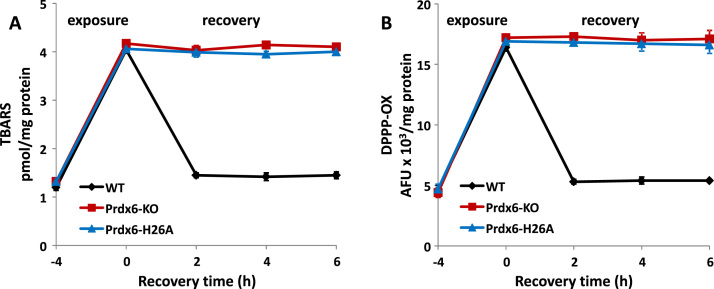
Repair of lipid peroxidation in pulmonary microvascular endothelial cells (PMVEC). PMVEC from Prdx6 null mice were infected with lentivirus to express vector alone (Prdx6 null), Prdx6 wild type (WT), or H26A-Prdx6.Cells were treated with 300 μM (WT) or 200 μM (null, H26A) t-BOOH for 4 h and then evaluated at intervals for recovery in medium free of t-BOOH by assay of: A. TBARS and B. DPPP-oxide.Values are mean ± SE for n = 3 to 4.